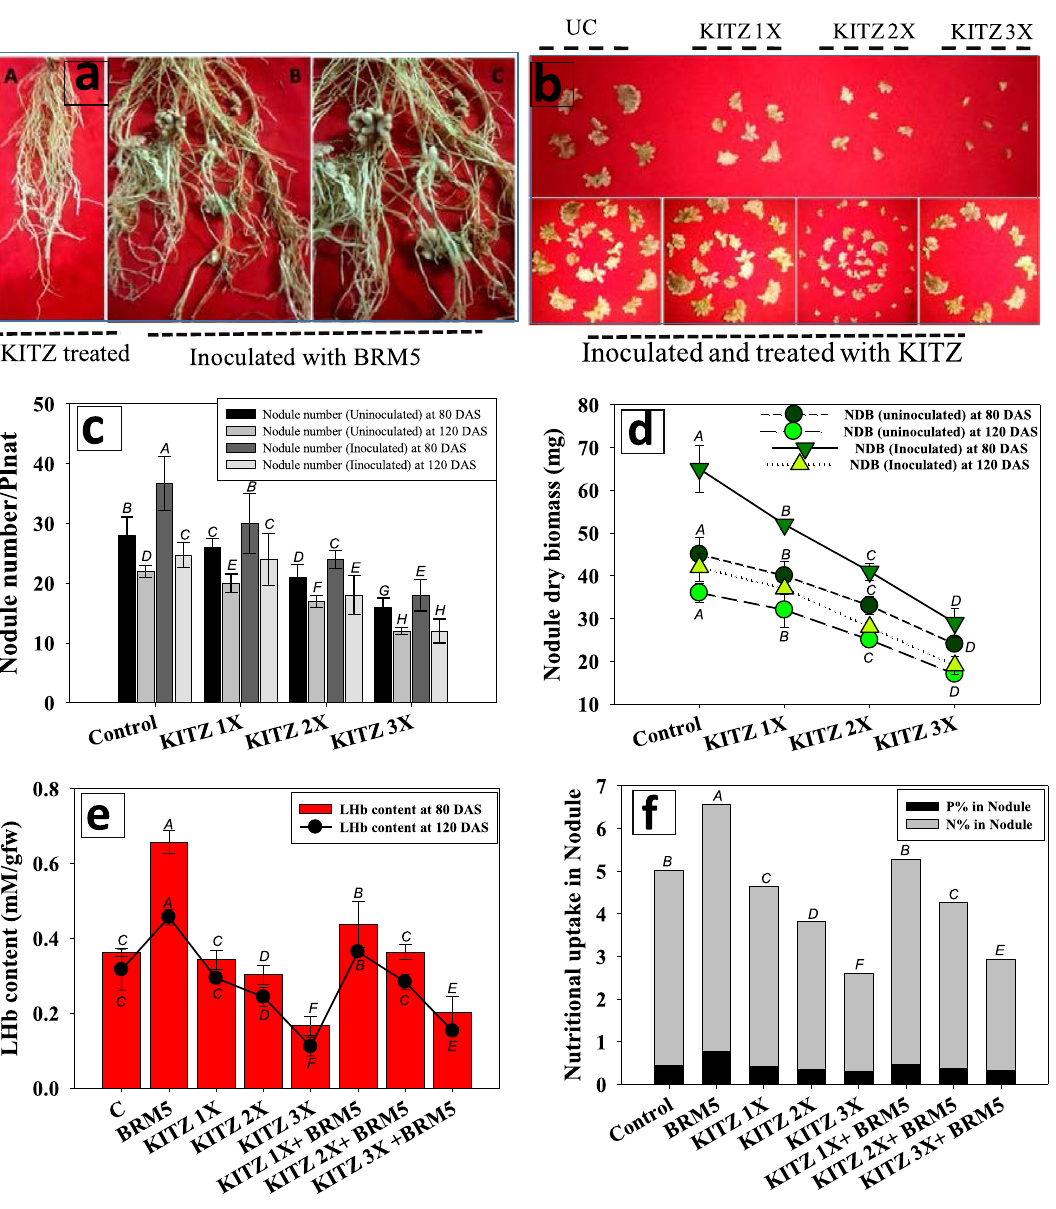
Figure 6. Bio-inoculation impact of M. ciceri BRM5 on symbiotic features of C. arietinum plants; attachment of nodules with inoculated and treated roots ( a ), morphology of nodule ( b ) nodule number ( c ), nodule dry biomass ( d ) and LHb content ( e ) and nutrient uptake in nodules ( f ) grown in sandy clay loam soil treated with 96 (1 ×), 192 (2 ×) and 288 (3 ×) µg KTZ kg −1 soil and harvested at different intervals. The bar and line diagrams represent the mean ± S.D ( n = 3) of three replicates where each replicate constituted three plants/pot. Mean values followed by different letters are significantly different at p ≤ 0.05 according to DMRT